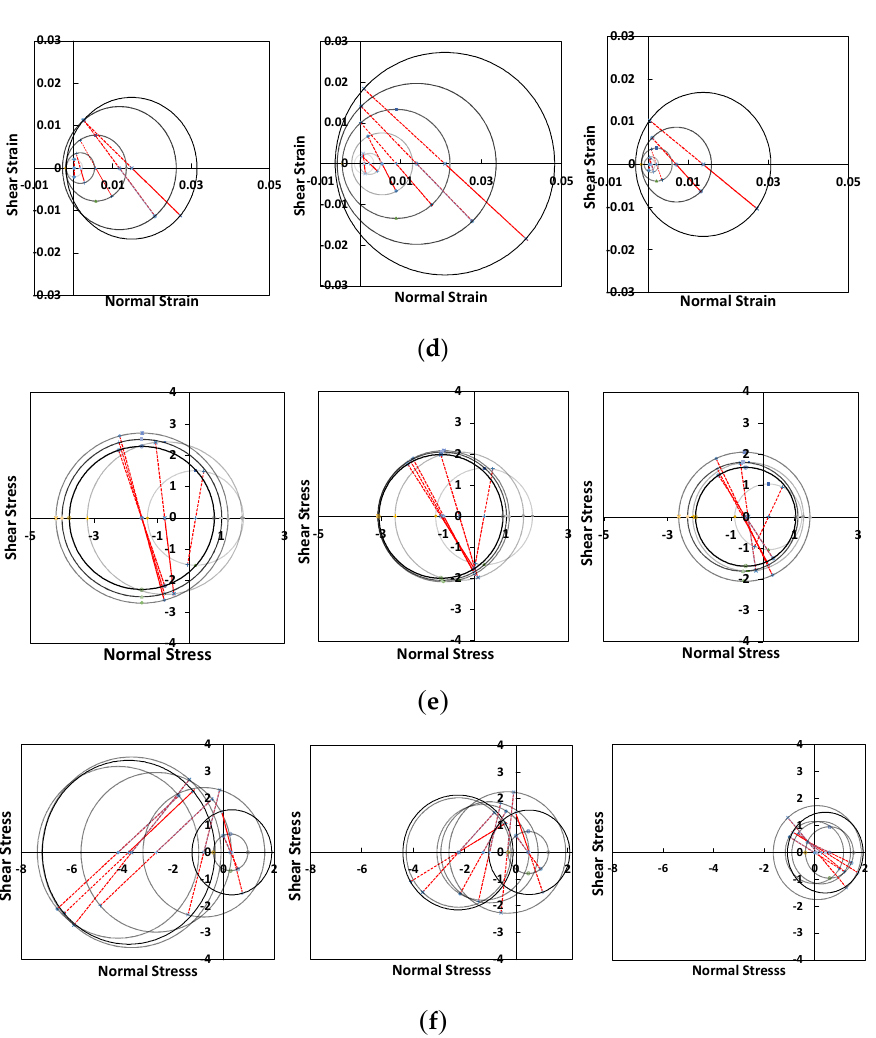
Figure 7. Variations in the angle of inclination of the web-shear crack according to the web shear force reinforcements. ( a ) Three windows in the web. ( b ) Shear distortions in web elements (10-fold magnification). Mohr’s circles showing ( c ) the ABAQUS strain, ( d ) the Vector2 strain, ( e ) the ABAQUS stress, and ( f ) the Vector2 stress.